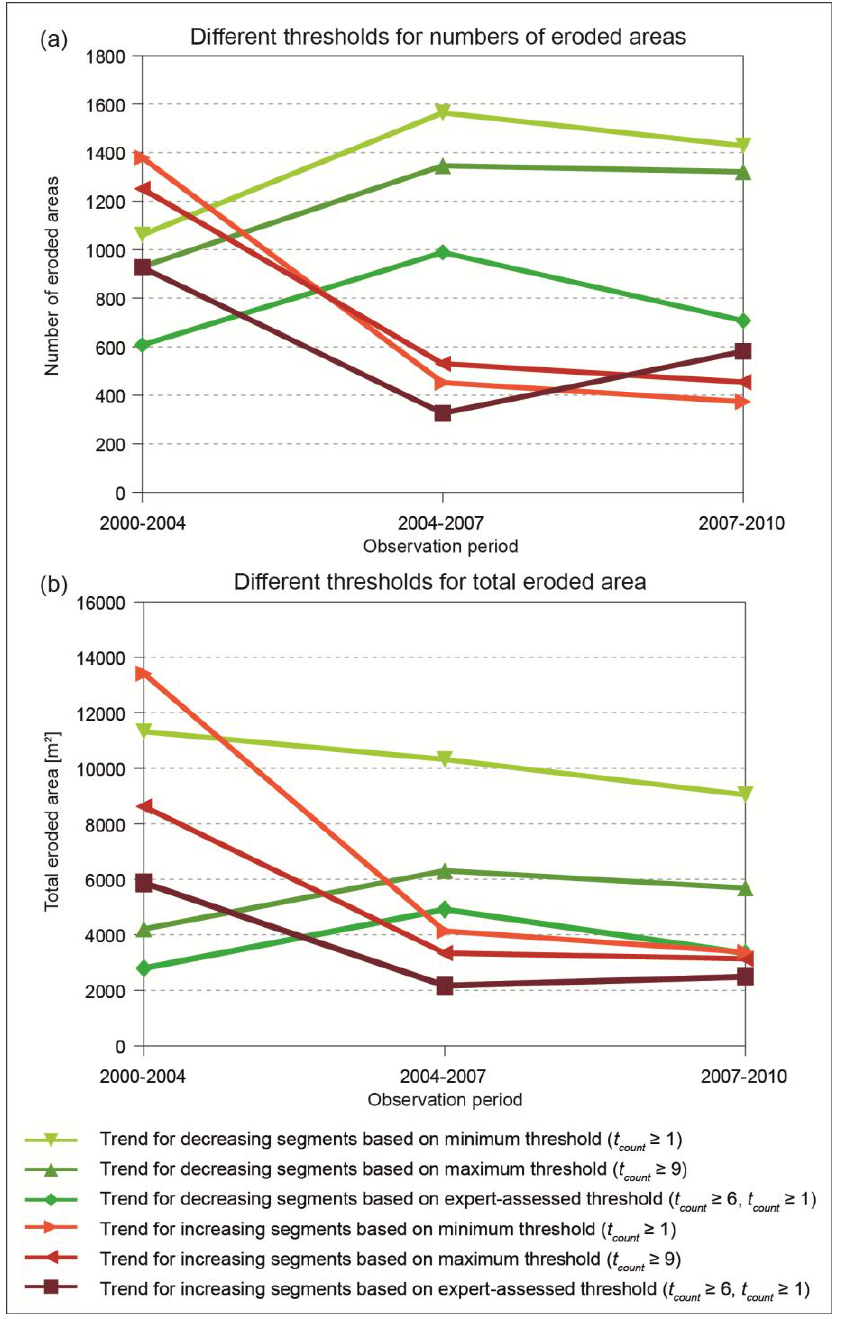
Figure 5. Trends for minimum ( t ≥ 1), maximum ( t ≥ 9) and expert-assessed count count ( t ≥ 6, t ≥ 1) thresholds. ( a ) Trends for changes in the number of all eroded areas count count based on the three thresholds; ( b ) trend for changes in the total eroded